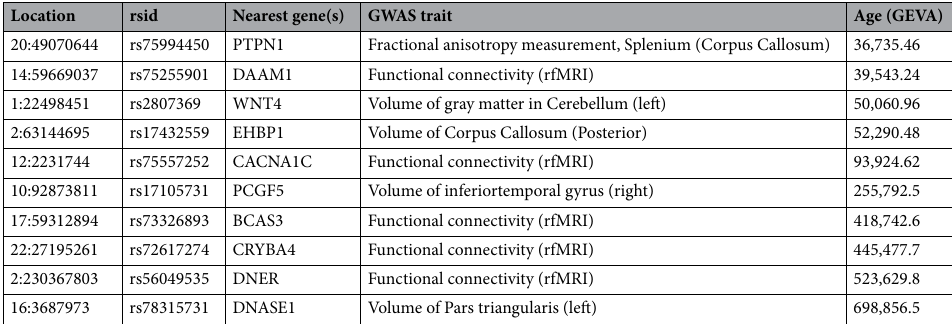
Table 1. Big40 Brain volume GWAS 46 top hits with high predicted gene expression in ExPecto ( log > 0.01 , RPKM), along with dating as provided by GEVA . ‘Functional connectivity’ is a measure of temporal activity synchronization between brain parcels at rest (originally defined in 51